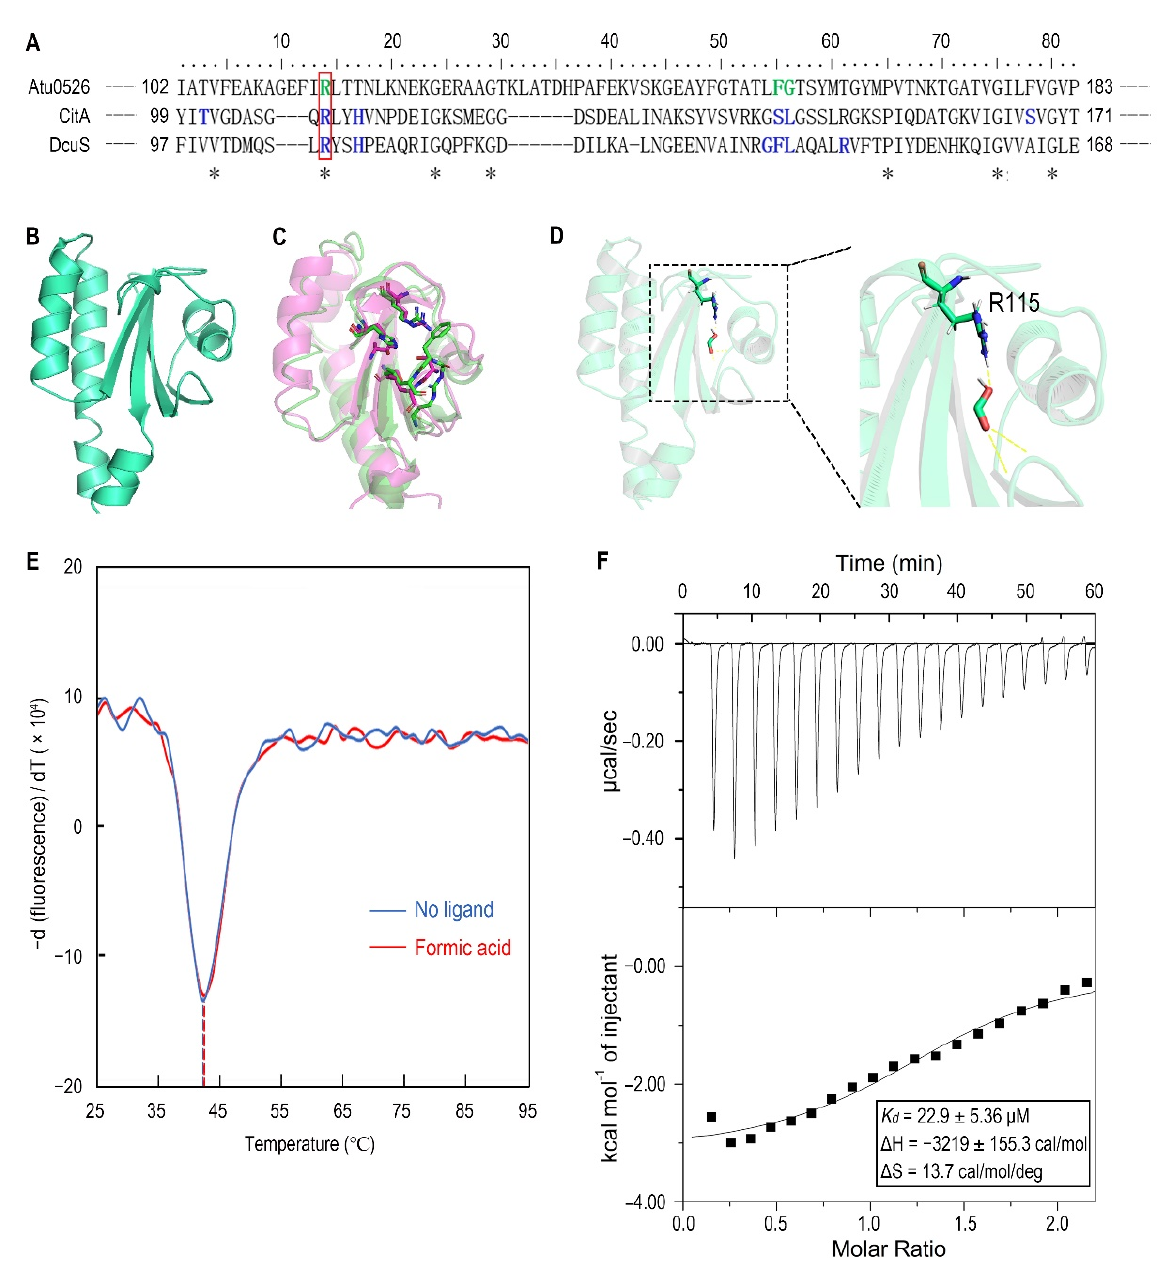
Figure 6. The analysis of R115 on the binding of formic acid to Atu0526 LBD . ( A ) Sequence alignment of sCache_3_2 domains of Atu0526, CitA and DcuS. * refers to identical residues. The residues shown in blue are residues of CitA and DcuS ligand binding. The residues shown in green were predicted to bind formic acid. The red rectangle indicates R115. ( B ) The predicted 3D structure of sCache_3_2 domain of Atu0526. ( C ) The 3D structures of sCache domains from CitA (magenta, 1P0Z) and DcuS (green, 3BY8). The important residues that ligands bind to are shown in stick form. ( D ) The docking of formic acid with Atu0526 LBD . The right part is an enlarged presentation of the content in the dashed box. The hydrogen bonds between the ligand and the protein are represented by yellow dashed lines. The R115 is in the stick diagram. ( E ) The binding analysis of formic acid to Atu0526 LBD R115A using a thermo shift assay. The data are presented in the form of changes in the derivative of fluorescence intensity with temperature. The temperatures corresponding to the red and blue dashed lines are the T m values of Atu0526 LBD R115A with and without formic acid, respectively. ( F ) Isothermal titration calorimetry of Atu0526 LBD R115A with formic acid. The upper panel depicts the raw titration data. The lower panel is the isotherm derived by integrating peaks from the raw data and the calculated values of K d , ∆ H and ∆ S. Data points were fitted with the “one binding site model” of